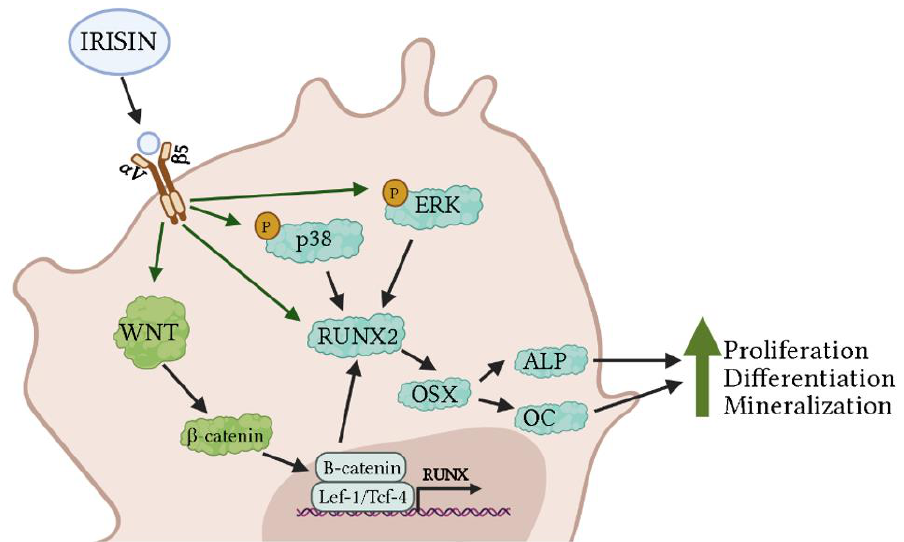
Figure 1. Effects of irisin treatment on osteoblasts in vitro. The figure is based on the data of the